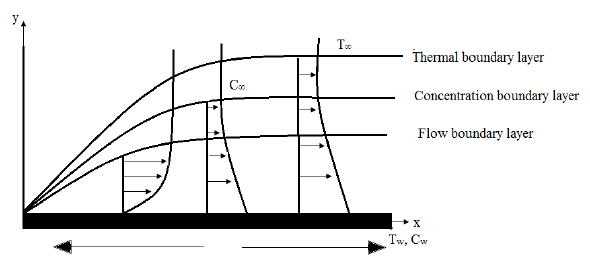
Fig. 1 Physical configuration of the